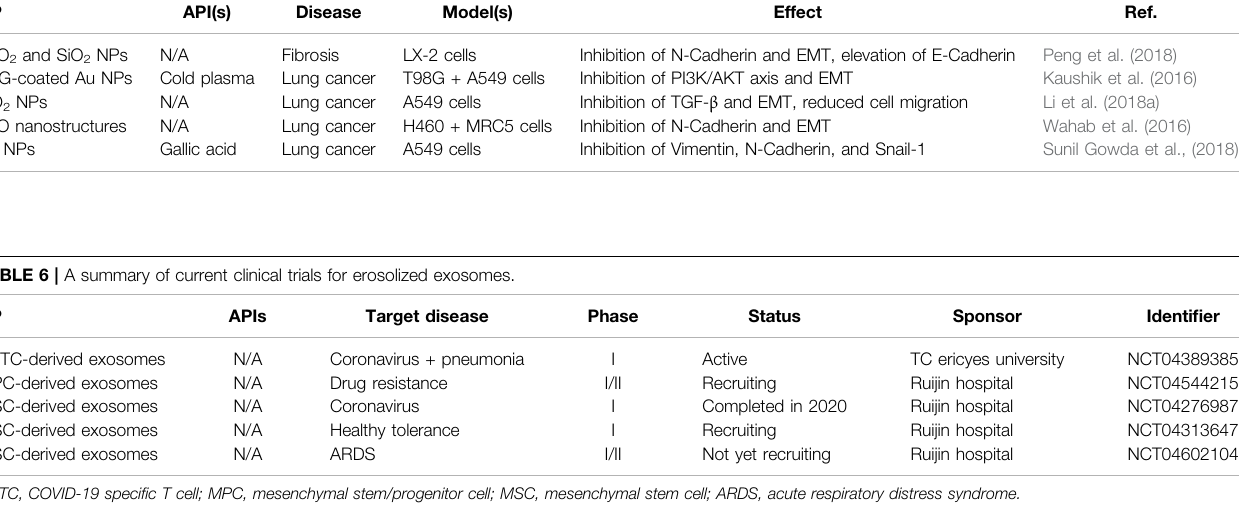
TABLE 5 | A summary of current erosolized inorganic NP formulations targeting EMT-markers in the literature. NP